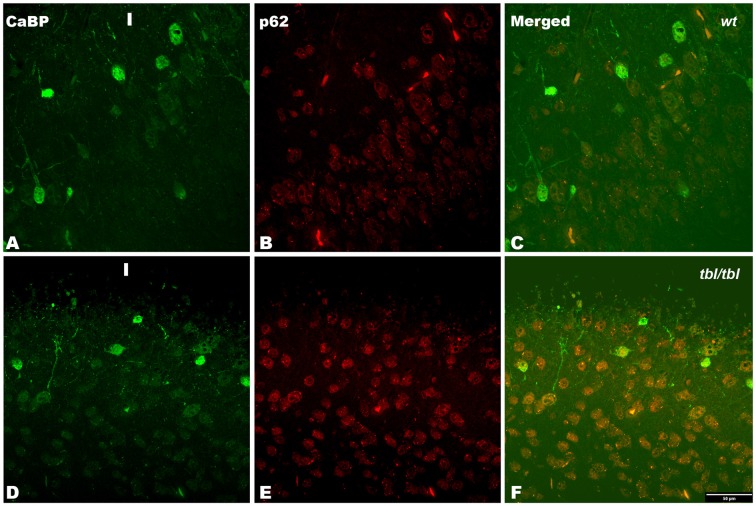
Confocal images of coronal sections through the frontal cortex layers II-III (A–C) of 4-month-old wt mice, and the frontal cortex (D–F) of 4-month-old tbl/tbl mice. p62 immunoreactive is stronger in tbl/tbl cortex (E) than in wt cortex (B); and in both wt
(C) and tbl/tbl
(F) co-express in calbindin (CaBP) immunoreactive neuronal cell bodies. I, layer I. Bars = 50 μm.